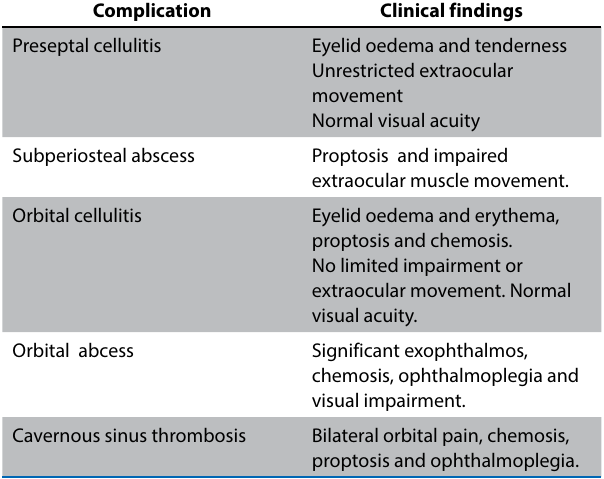
Table I. Chandler’s classification of orbital complications